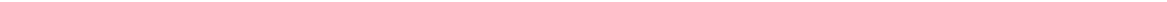
Fig. 4 SP5 regulates expression of developmental regulators. a Altered gene expression in WNT-treated SP5 mutant cells. A heatmap of gene expression illustrates differences between WT and SP5 mutant (dZF1 and 2) hESCs. Genes are in order of the clusters identi fi ed in Fig. 1c; expression is given as percent WT maximum RPKM (0, white; 100, blue; ≥ 100, red). Refer to Supplementary Data 3 for complete gene list. b Representative upregulated genes. The average change in percent maximum RPKM of dZF 1 and dZF 2 vs. wild-type illustrates upregulation of many developmental regulators ( − 1, indigo; 0, white; 1.0, red). Genes in red contain a SP5 peak. *SP5 peaks near FOXA2 and SOX17 were called at a lower con fi dence ( p < 10 − 4 vs. p < 10 − 5 ) and were not included in the list of 662 SP5 peaks. c SP5 peaks are enriched among genes with the most signi fi cant fold changes upon WNT treatment. For each gene set (A through D), the table provides the p -value for the least signi fi cantly changed gene (as described by Trapnell et al. 52, 53 ). Refer to Supplementary Data 4 for gene lists. The graph indicates the fraction of genes with SP5 peaks among gene sets A through D. d Genes with SP5 peaks are associated with early embryonic development. Gene ontology (GO) analysis reveals that genes with SP5 peaks of gene set C are highly enriched for genes associated with “ primitive streak formation ” . e Validation of upregulated genes. WT and dZF mutant hESCs were treated with 1 nM Wnt3a for the indicated times and RNA was isolated and analyzed by qPCR for expression of SP5 . Genome browser tracks illustrate the increase of SP5 binding near the transcriptional start site. Additional examples are provided in Supplementary Fig. 5. Arrows indicates direction of transcription. RQ relative quantity. (Error bars are SEM for four technical replicates; Student ’ s t test: * p < 0.05; ** p < 0.01; **** p < 0.0001). f Extended Wnt3a treatment of hPSC. WT and SP5 mutant (dZF2) cells were treated with Wnt3a for the indicated times and RNA was analyzed by qPCR for SP5